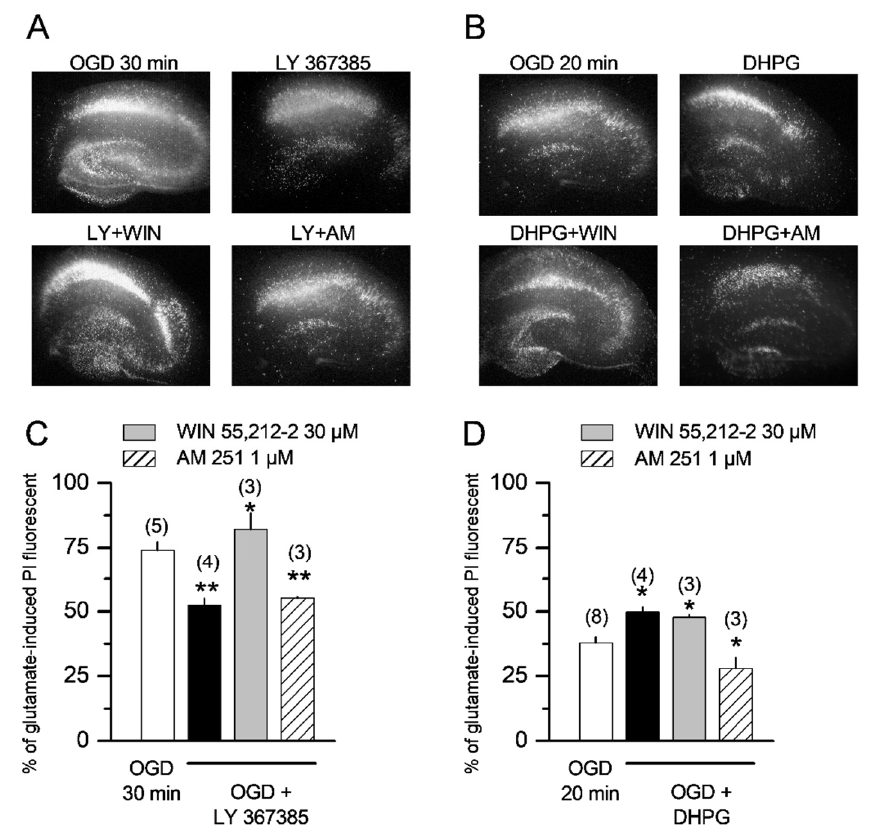
Figure 3. The neuroprotective effects of the mGlu1 antagonist LY367385 and the toxic effects of the mGlu1 agonist DHPG are reverted by CB1 receptor ligands in organotypic hippocampal slices exposed to OGD. ( A , C ) Qualitative and quantitative analysis of organotypic hippocampal slice exposed to OGD, displaying a selective increase in PI fluorescence in the CA1 subregion. The CB1 agonist WIN 55,212-2, but not the CB1 antagonist AM 251, reverts the neuroprotective effects of 300 µ M LY367385 against 30 min OGD injury. ( B , D ) Qualitative and quantitative analysis of organotypic hippocampal slice exposed to OGD, showing that the CB1 antagonist AM 251, but not the CB1 agonist WIN 55,212-2, reverts the exacerbation of 20 min OGD injury induced by 100 µ M DHPG. Drugs were present in the incubation medium during OGD and the subsequent 24 h recovery period. Bars represent the mean ± SEM, the number of experiments (run in quadruplicate) is shown in parenthesis. * p < 0.05 and ** p < 0.01 vs. OGD, respectively (ANOVA + Tukey’s w